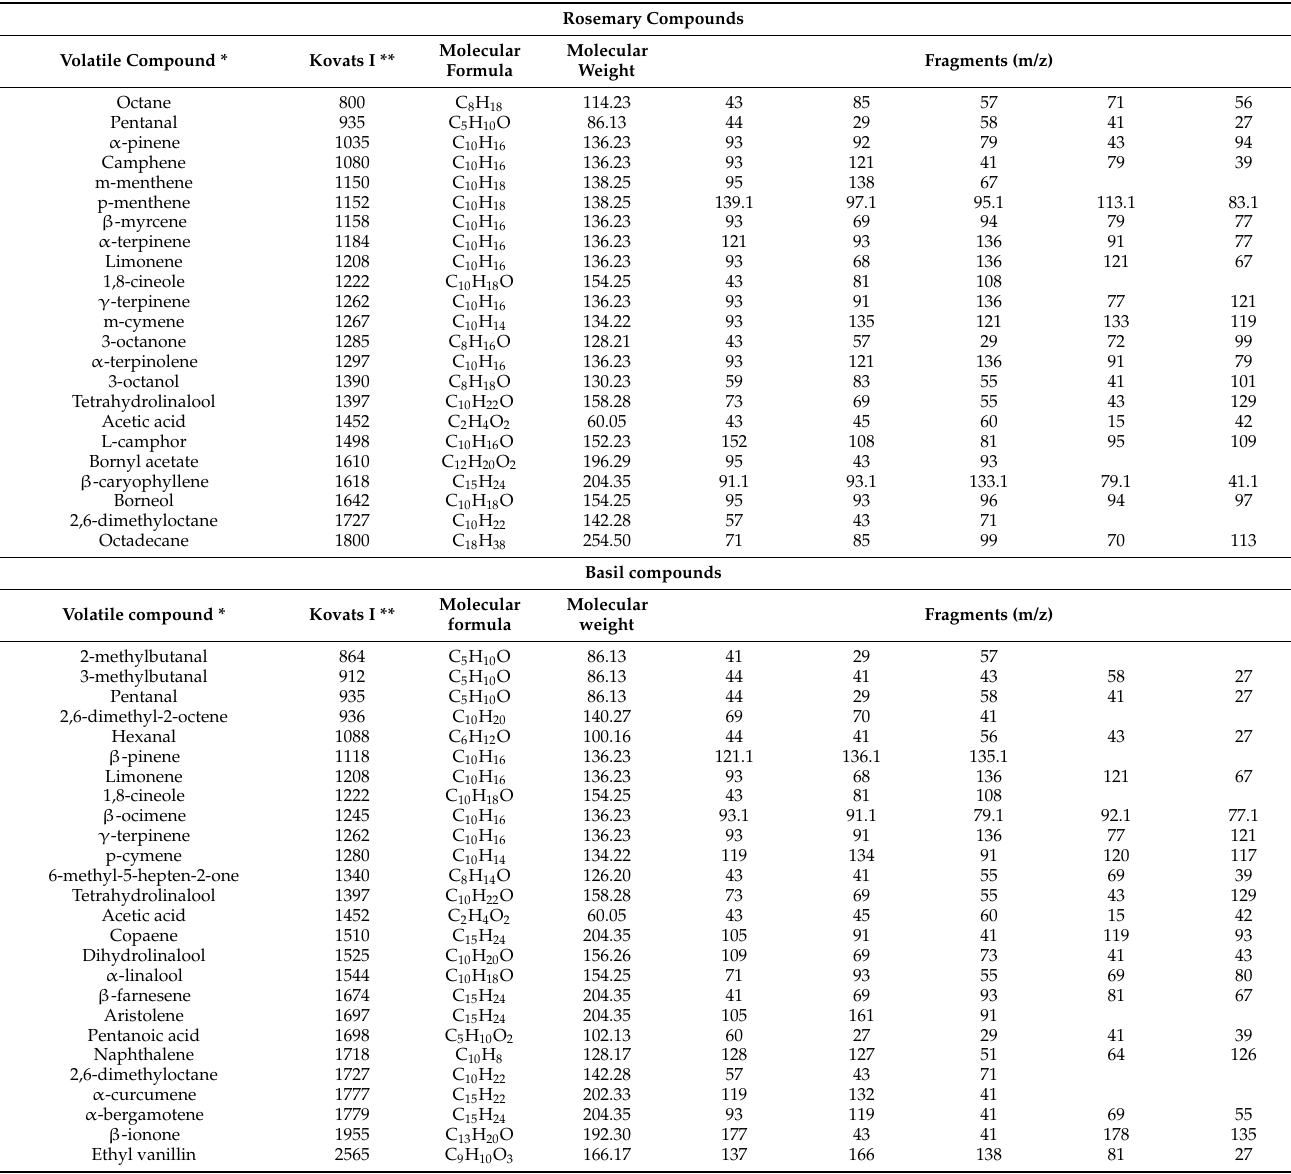
Table 3. Volatile compounds identified in rosemary and basil herbs by